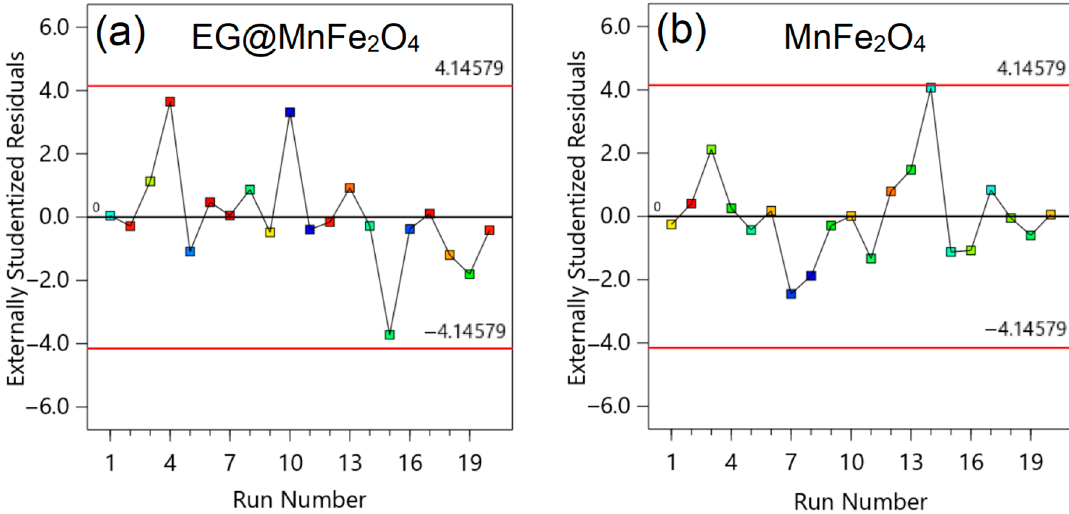
Figure 7. Residuals versus run plots for the adsorption of CR onto EG@MnFe 2 O 4 ( a ) and MnFe 2 O 4 ( b ).